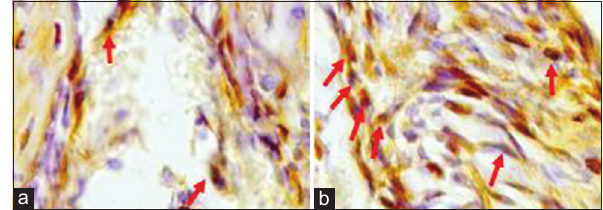
Figure-1: Vascular endothelial growth factor expressions in the control group (a) and in the treatment group (b).